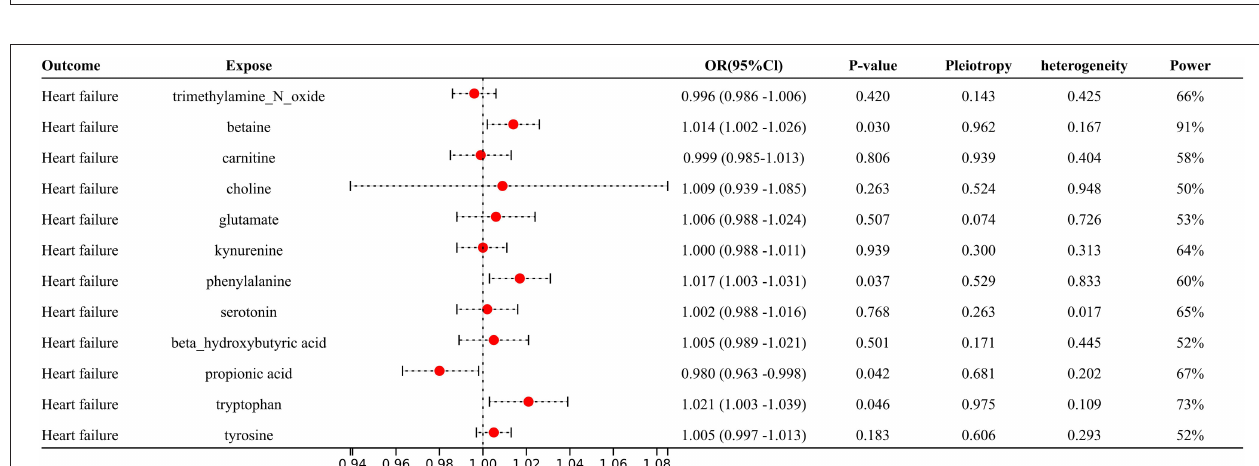
FIGURE 3 | Forest plot to visualize the causal effect of Gut microbiota on the risk of heart failure risk factors by inverse variance weighted method.